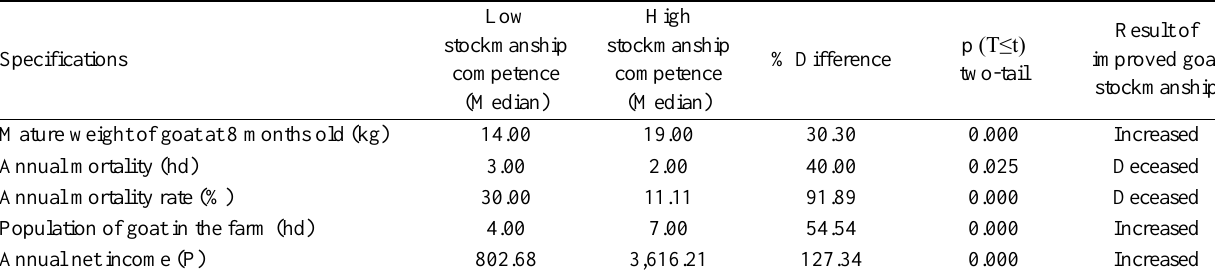
Table 2. Productivity and income in low and high stockmanship competence